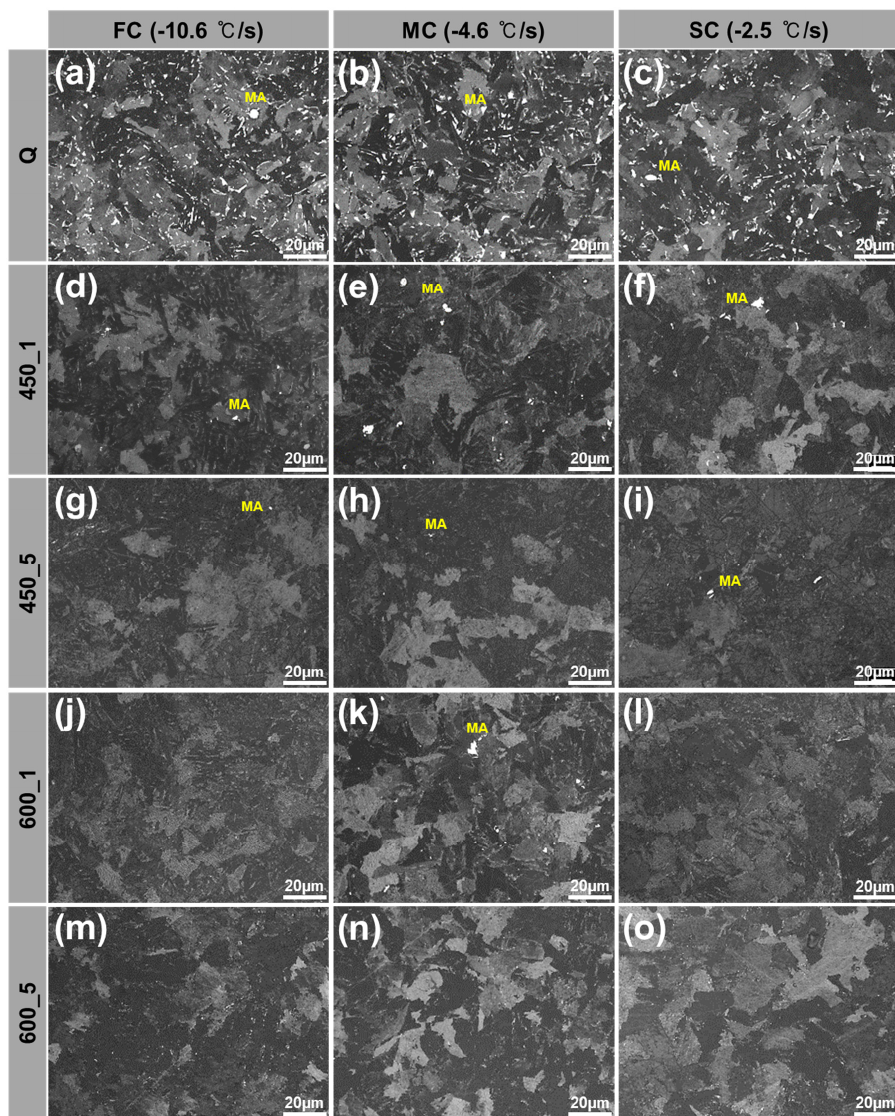
Figure 5. Optical micrographs of microstructure etched by Klemm’s I to distinguish MA (colored as white) according to various CRs and heat treatment conditions: ( a , d , g , j , m ) FC (−10.6 °C/s), ( b , e , h , k , n ) MC (−4.6 °C/s), ( c , f , i , l , o ) SC (−2.5 °C/s), ( a – c ) Q, ( d – f ) 450_1, ( g – i ) 450_5, ( j – l ) 600_1, ( m – o ) 600_5.